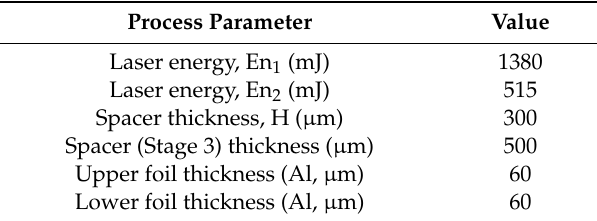
Table 7. Process